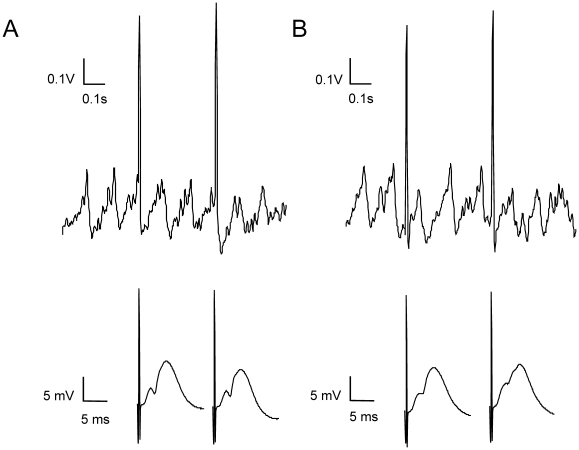
fEPSP profile depends on the timing of the stimulation-induced theta phase.(A) Sample EEG trace from a case with stimulation-induced theta oscillations, where positive peaks coincide with entorhinal stimuli (upper trace). The same field potentials represented in ms time scale (bottom traces) show a clear population spike. (B) Sample EEG trace from a case with stimulation-induced theta oscillations, where the positive peaks do not coincide with the entorhinal stimuli (upper trace). The population spike of the same field potentials, measured at ms time scale (bottom traces) is almost absent.